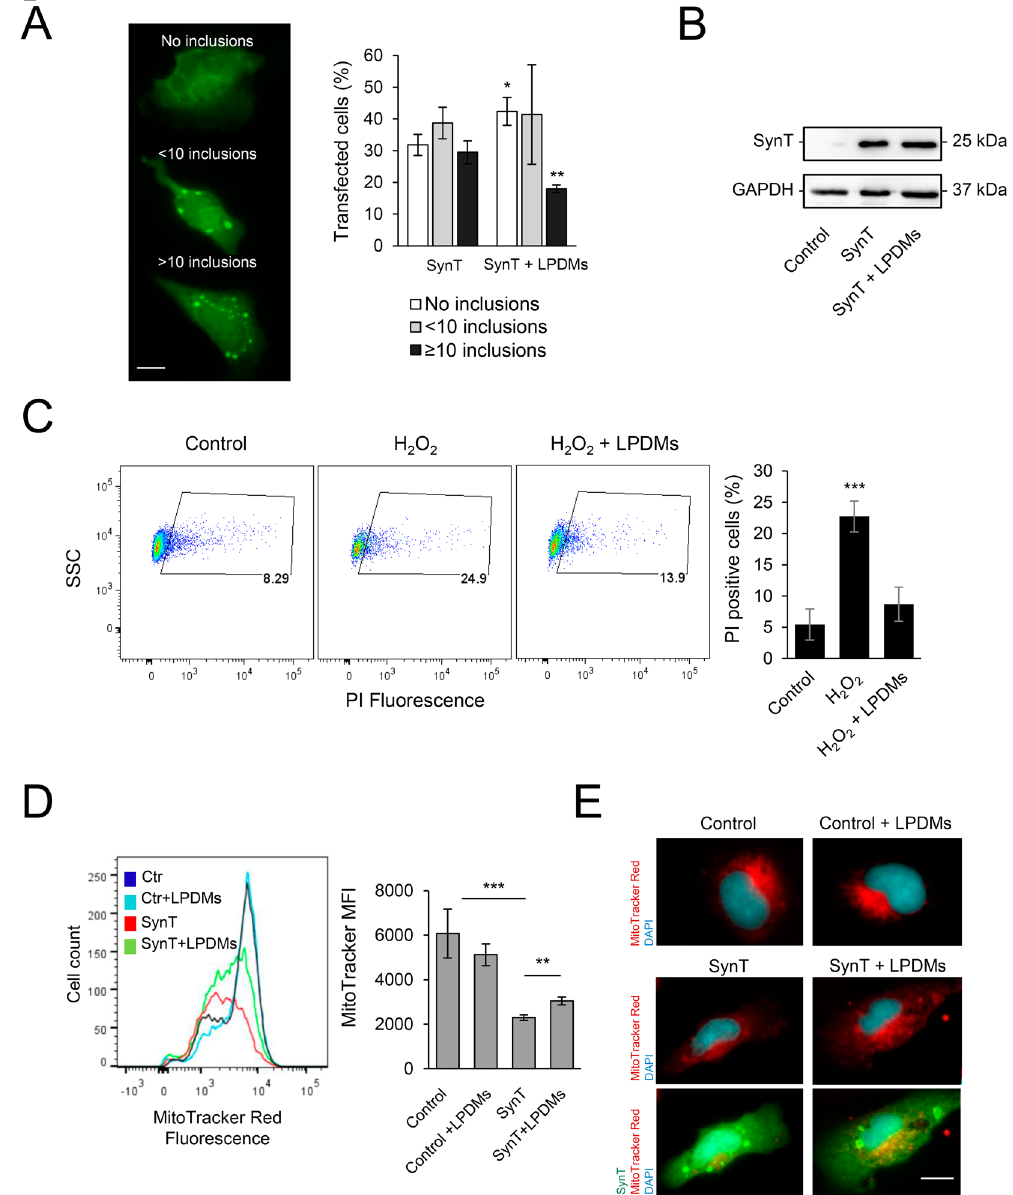
Figure 5. A. unedo LPDMs modify the distribution of aSyn inclusions, protect from H 2 O 2 -induced toxicity and promote mitochondrial function in H4 cells. ( A ) H4 human neuroglioma cells were transfected with SynT (SynT and Synphilin-1) for 24 h and treated with 2 µ g GAE.mL − 1 LPDMs for 6 h. Subsequently, cells were subjected to immunofluorescence labeling and the percentage of cells with inclusions was determined by fluorescence microscopy (left panel). Cells were classified by cells without inclusions ( □ ), with less than 10 inclusions ( ), or with 10 or more inclusions ( ■ ) (right panel). Scale bar: 10 µ m. ( B ) SynT levels of H4 cells transfected with the empty vector (control), co-transfected with SynT and Synphilin-1 (SynT) or treated with LPDMs (SynT + LPDMs), assessed by western blot. GAPDH was used as loading control. ( C ) H4 cells were pre-treated with PDMs for 16 h, then subjected to 600 µ M of H 2 O 2 for 6 h. Viability was assessed by PI fluorescence versus side scatter (SSC), determined by flow cytometry. PI positive cells are gated, and the respective percentage is presented, statistics were performed in comparison to the control. ( D ) Mitochondrial membrane potential evaluated using MitoTracker Red by flow cytometry; histogram of MitoTracker Red fluorescence (left panel) and respective median fluorescence intensity (MFI) (right panel) of H4 cells transfected with the empty vector (control), co-transfected with SynT and Synphilin-1 not treated (SynT) or treated with LPDMs (SynT + LPDMs). ( E ) H4 cells transfected with the empty vector (control), co-transfected with SynT and Synphilin-1 (SynT) or treated with LPDMs (SynT + LPDMs) were immunostained for SynT (green). Mitochondria were visualized using MitoTracker Red (red) while Nuclei were stained with DAPI (blue). Scale bar, 10 µ m. A representative result is shown, and values represent the mean ± SD of at least three independent experiments. Statistically significant differences between the indicated treatments are shown, * p < 0.05, ** p < 0.01, *** p < 0.001. Full-length immunoblots are shown in Supplementary Figure